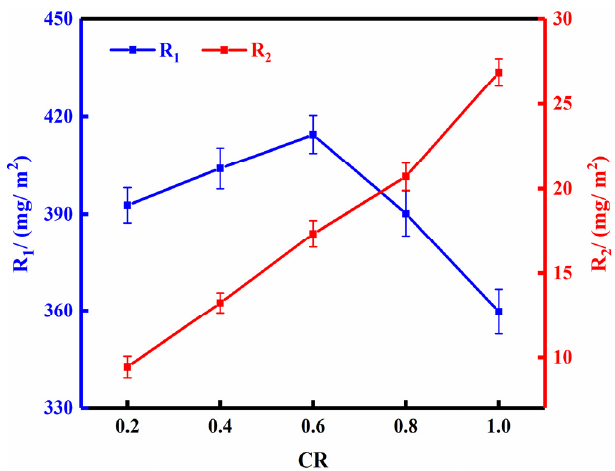
Figure 6. The effect of CR on drug loading of bamboo strips.